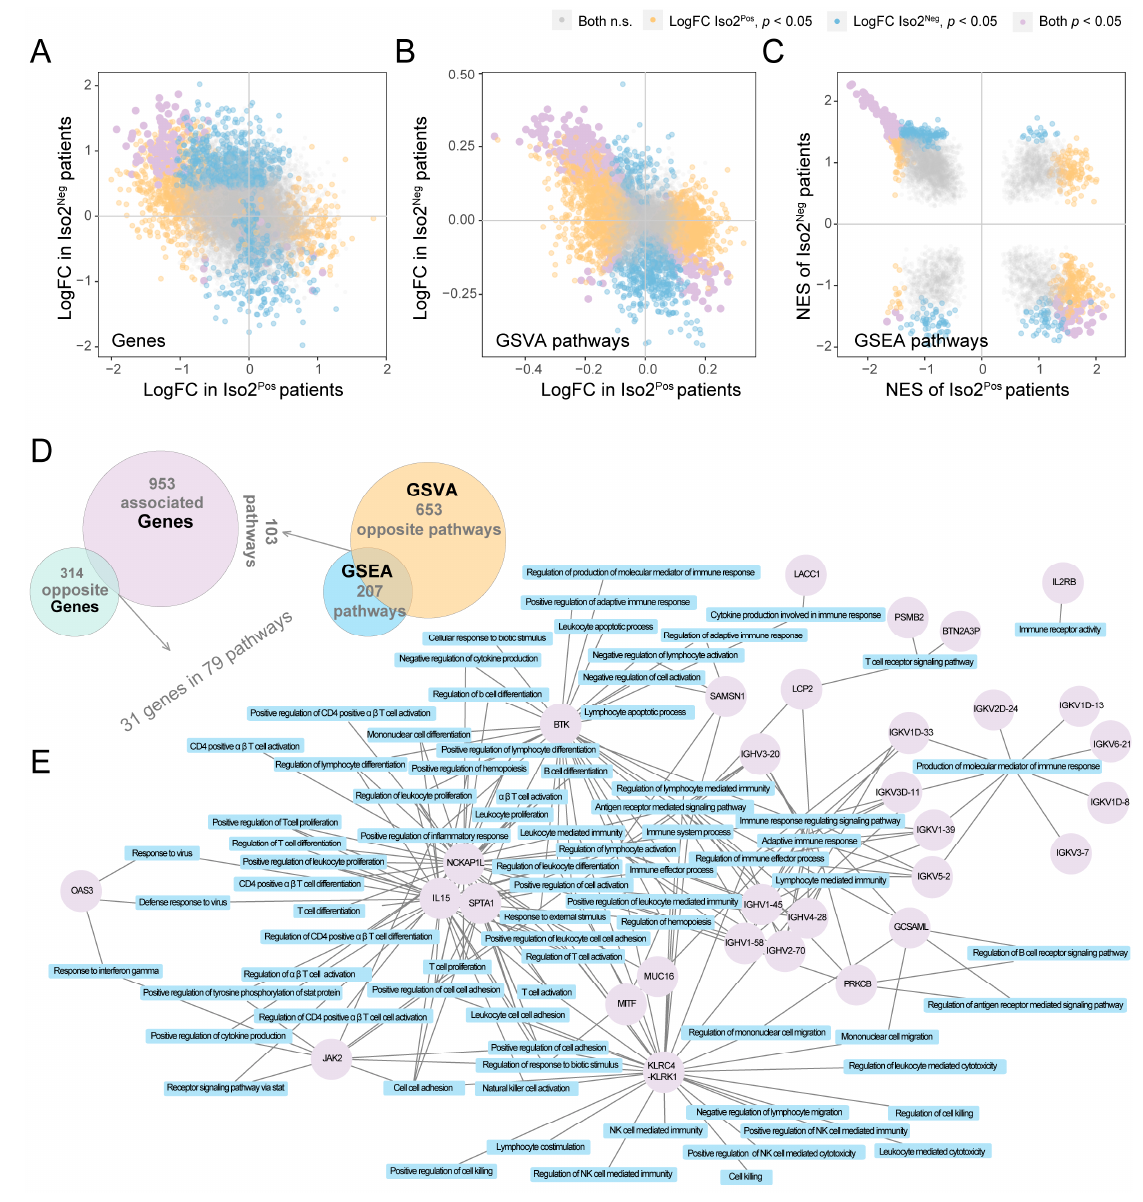
Figure 4. Changed or reversed functions of Iso1 under the expression switch of Iso2 from positive to negative. ( A – C ) Genes, GSVA and GSEA pathways significantly associated with Iso1 in Iso2 Pos and Iso2 Neg patients. ( D , E ) Intersected DEGs and pathways from the aforementioned analysis.